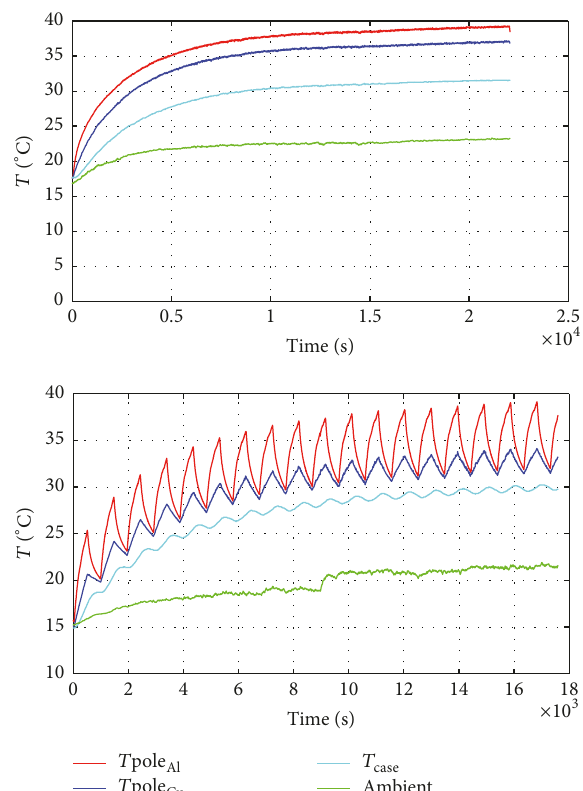
Figure 6: Output measurement profiles for measurement sets 1, 2.